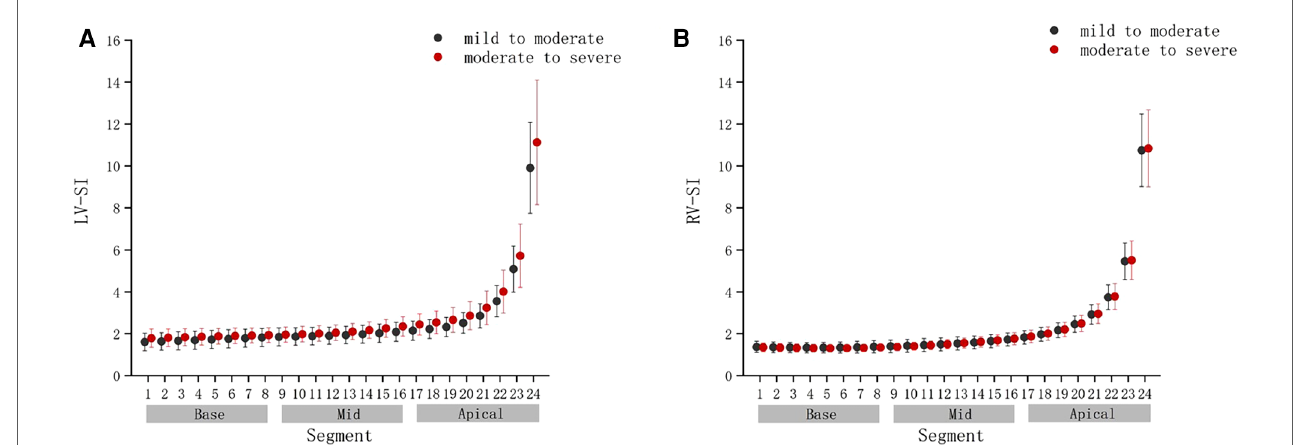
FIGURE 5 Comparison of ventricular 24-segment sphericity index (SI) from the base to the apex between the mild to moderate group and moderate to severe group. ( A ) Left ventricle (LV) 24-segment SI values in the mild to moderate group and moderate to severe group. ( B ) Right ventricle (RV) 24-segment SI values in the mild to moderate group and moderate to severe group.